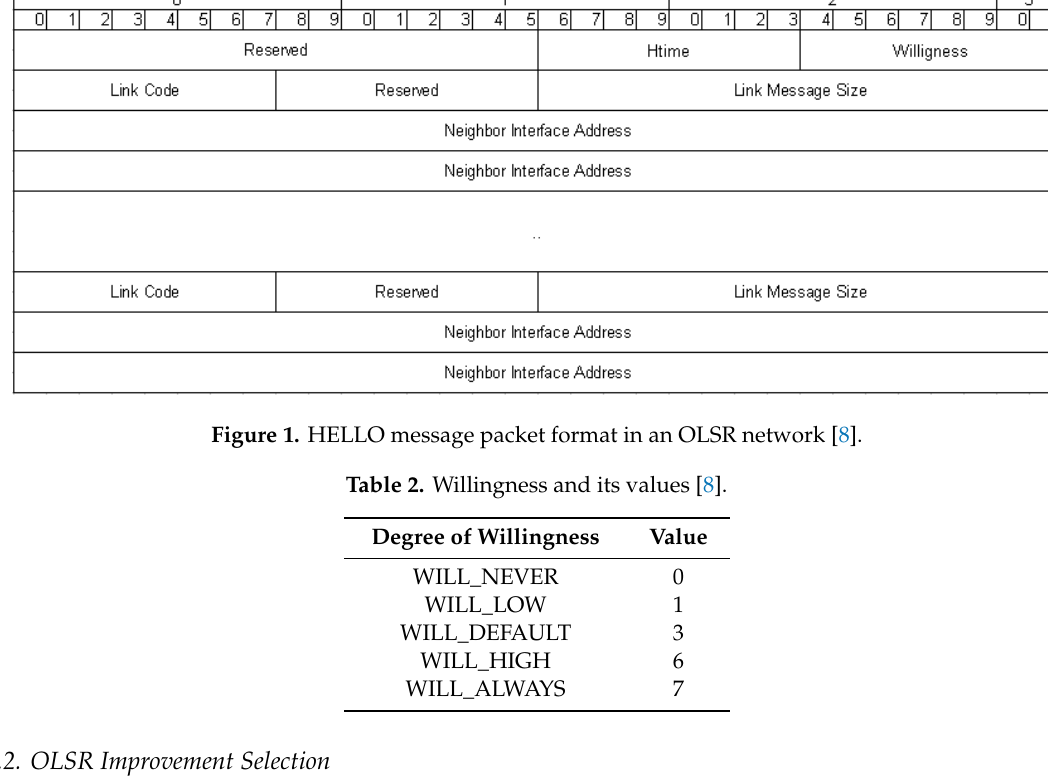
Table 3. The duality of game and wireless ad-hoc network.